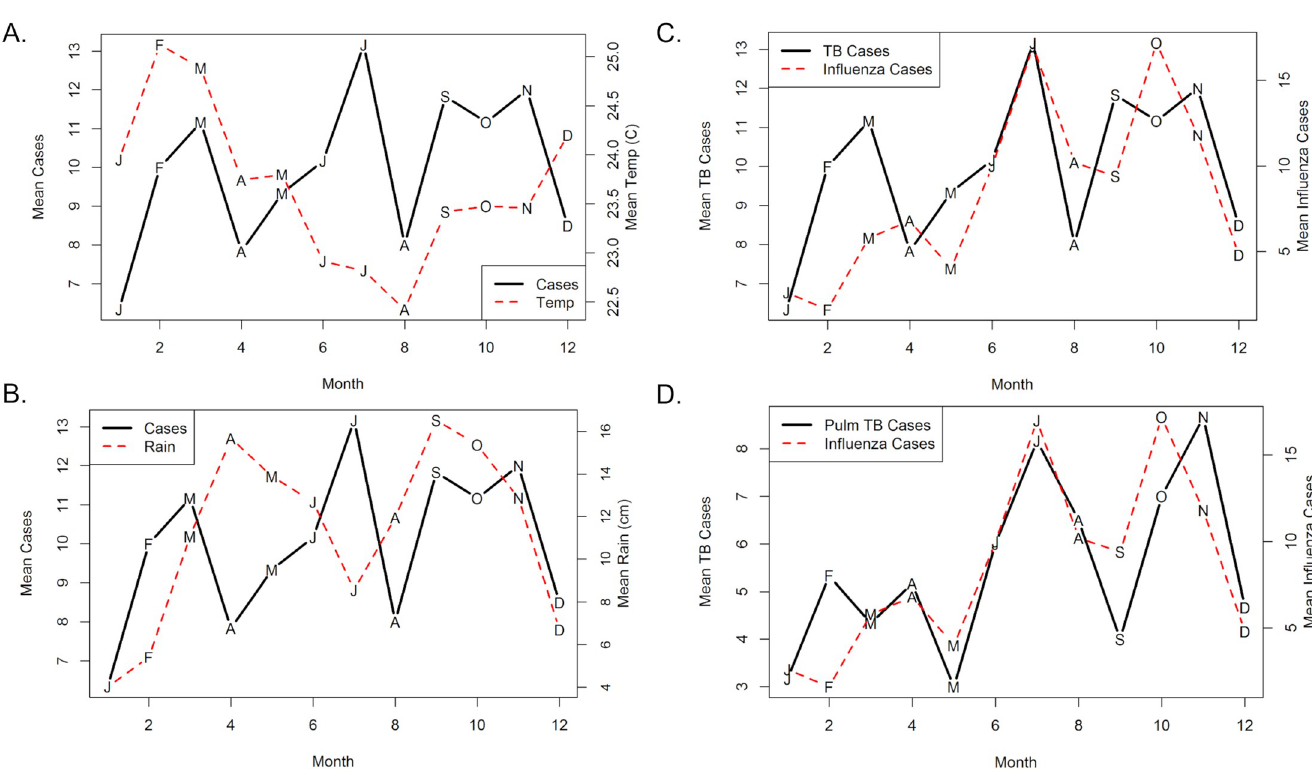
Fig 4. Monthly mean plots of pediatric TB cases vs. Temperature, rainfall and influenza cases. (A) Pediatric TB Cases vs. Temperature. Months indicated by letters. (B) Pediatric TB Cases vs. Rainfall. (C) Pediatric TB Cases vs. Influenza Cases. Data on influenza cases available from 2010–2014. (D) Pediatric Pulmonary TB Cases vs. Influenza